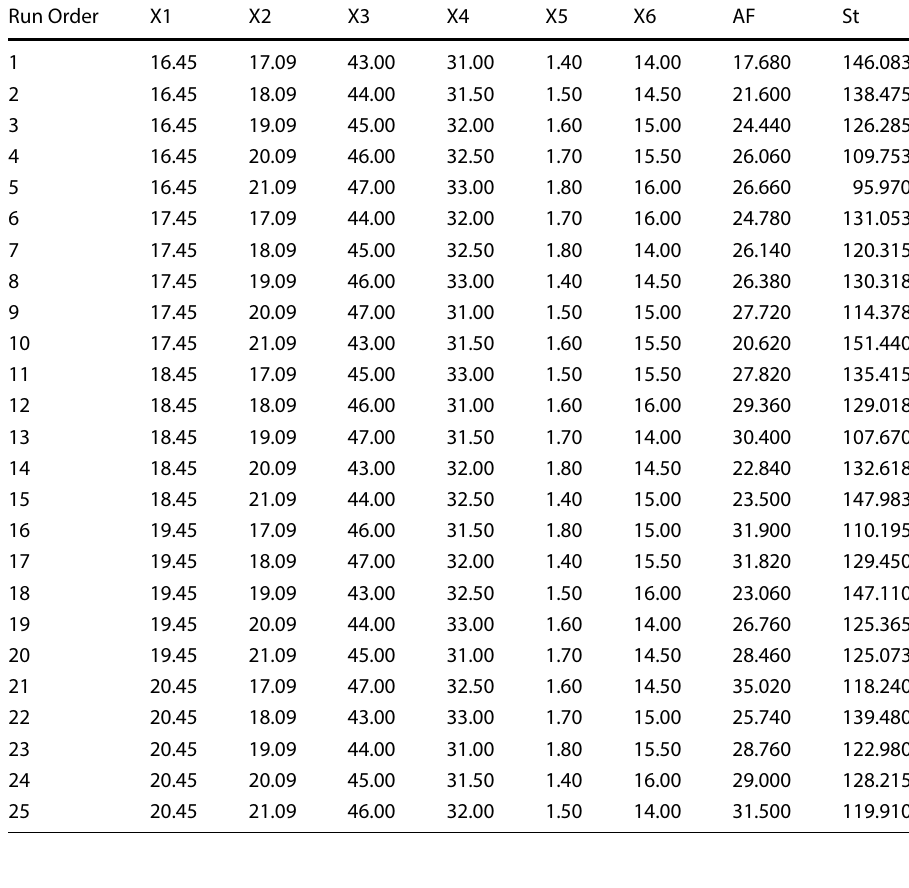
Table 5 Results (performed experiments by FEM) based on Taguchi L25